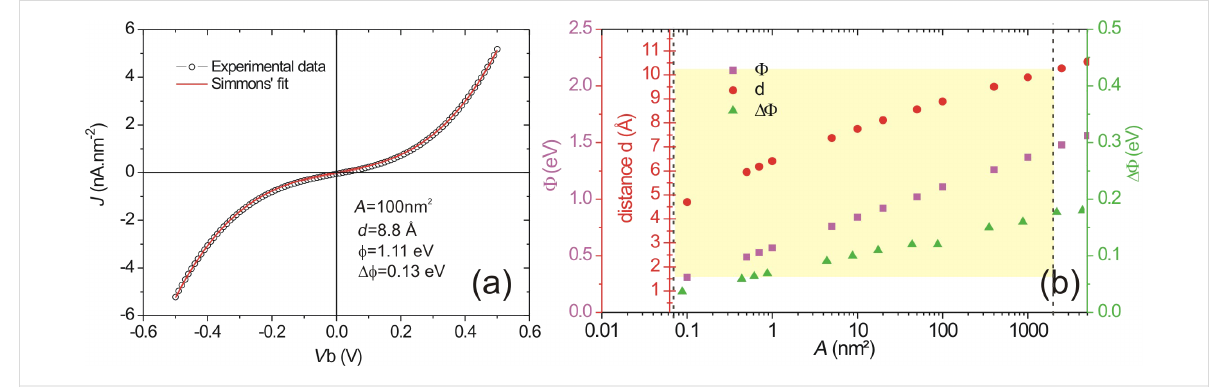
Figure 3: (a) Current density J T plotted versus applied bias V dc . The black circles are experimental data points and the solid red line is the best fit to the data using Simmons’ model of tunneling transport. (b) The fitting parameters , Δ , and d as functions of the junction area A . The yellow frame represents a parameter space consistent with respect to the experimental measurements.